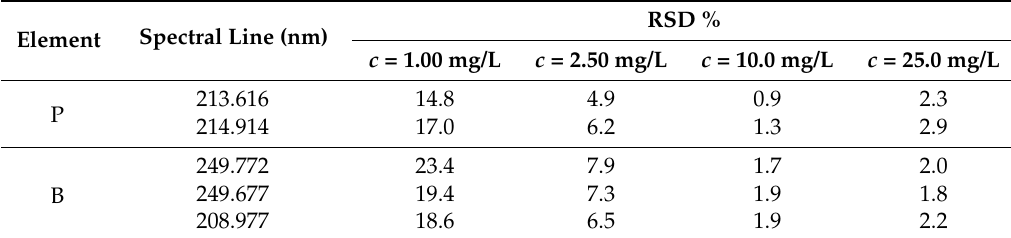
Table 6. Method repeatability.